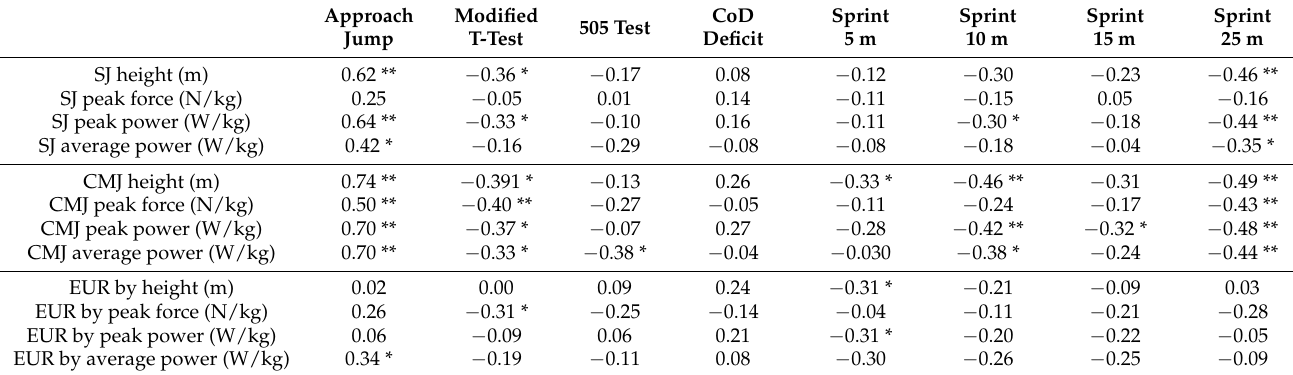
Table 2. Correlations among basic jump outcomes and eccentric utilization ratio and performance measures. Approach